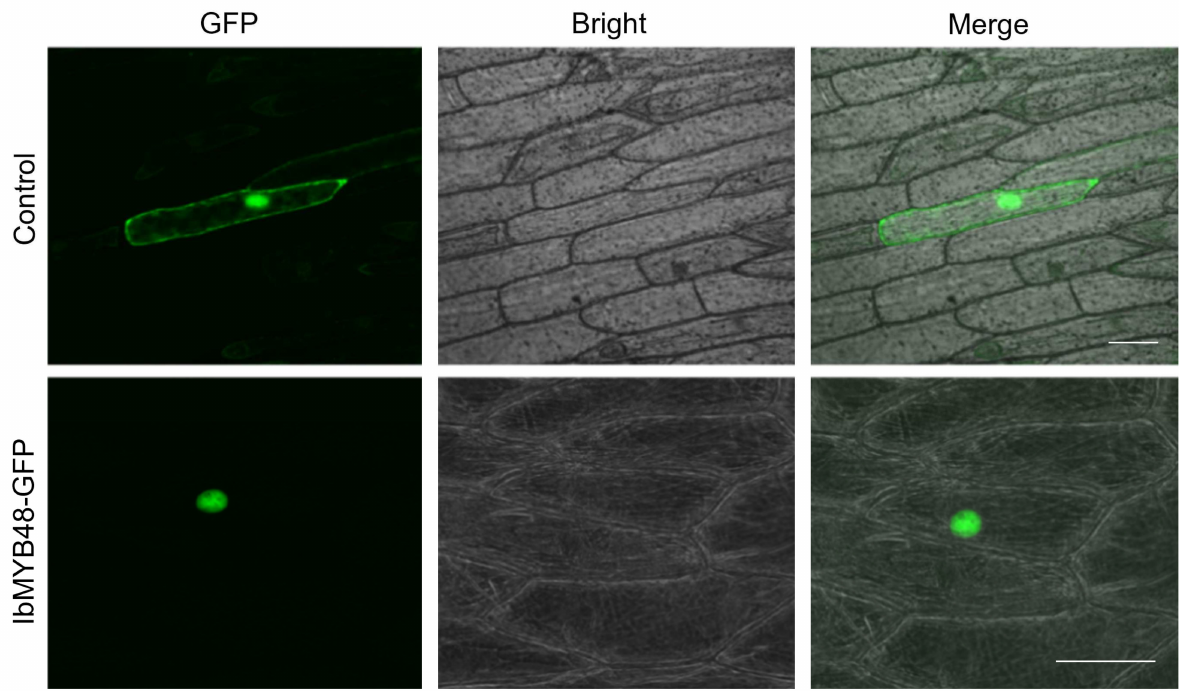
Figure 3. Transient expression and localization analysis of IbMYB48-GFP in onion epidermal cells. Specimens were observed using fluorescent microscope Nikon TE-2000E with 488 nm excitation wavelength laser. Bars = 30 µ